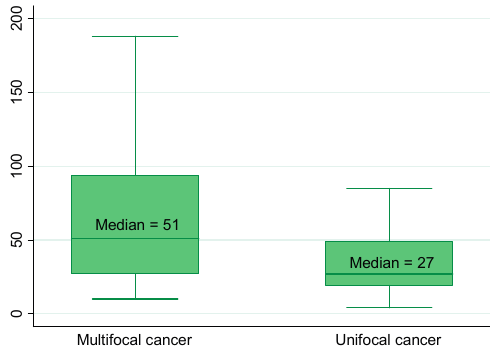
Figure 4. Median PCA3 score according to number of prostate cancer foci ( p = 0.002). Biological and pathological findings in 154 men who underwent radical prostatectomies for prostate cancer. (See the note in the legend of the Figure 1 for complete explanation of how to read the figure).